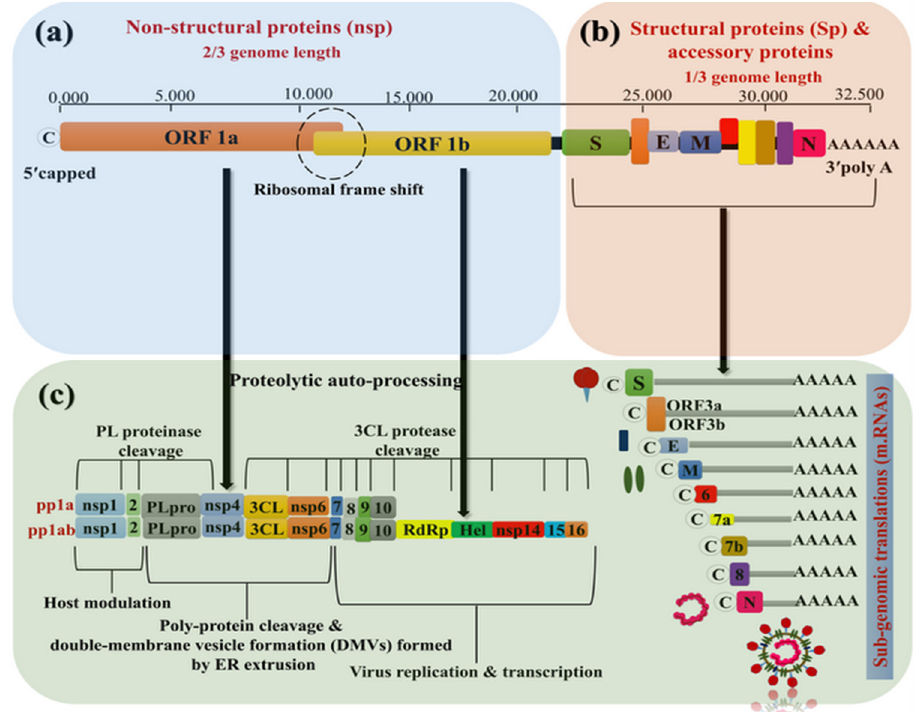
Figure 3. SARS-CoV-2 genetic map. ( a ) The genetic arrangement of the virus codons from 5’ capped to ( b ) 3’ poly-A tail, and ( c ) the post-translation process of the nonstructural, accessory, and structural